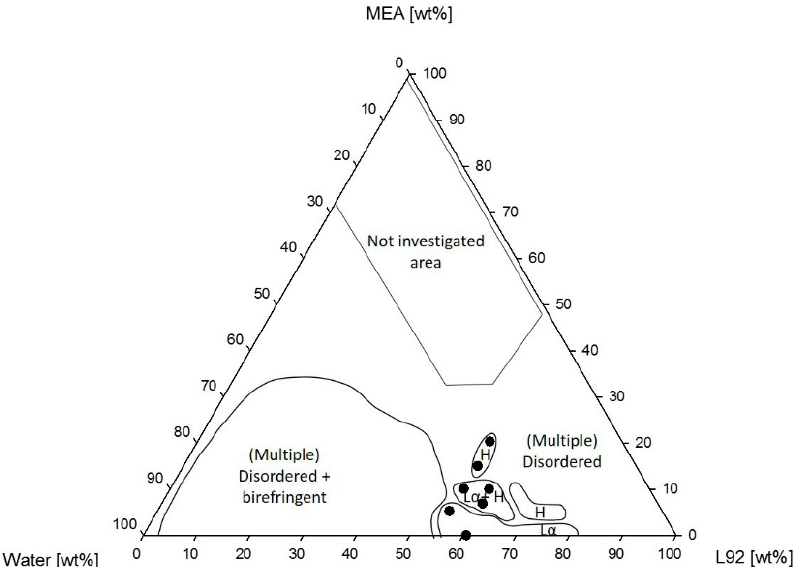
Figure 3 . Phase diagram of Pluronic L92/water/MEA.